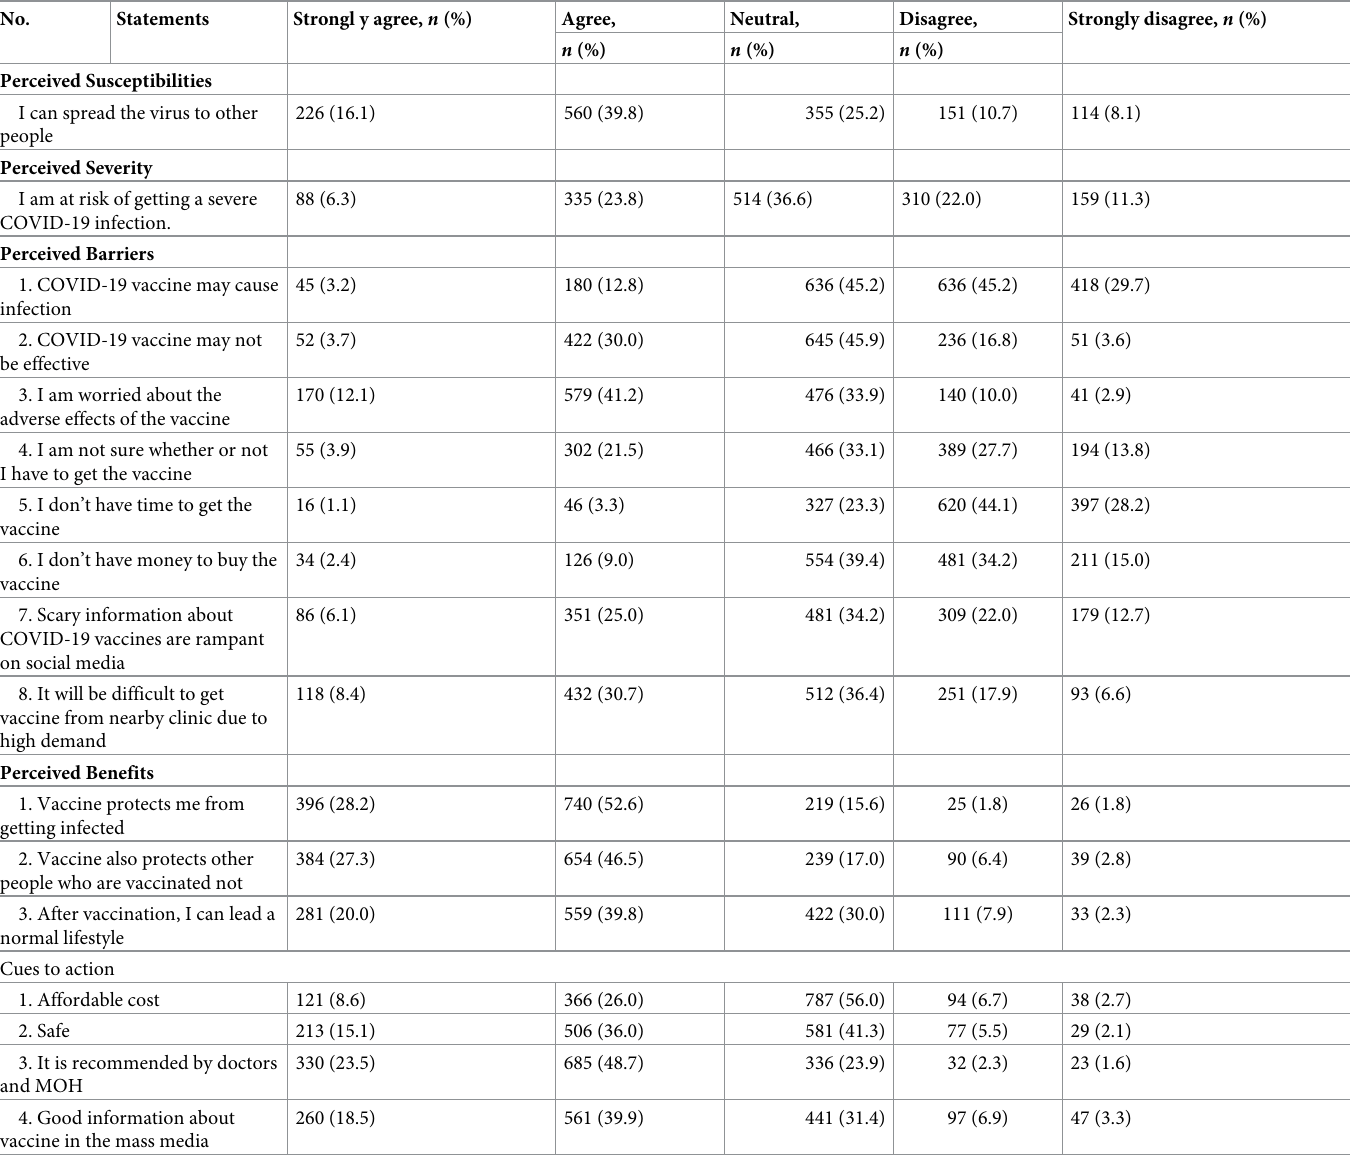
Table 6. Perception on susceptibilities, severity, barriers and benefits, and cues to action (N = 1406).